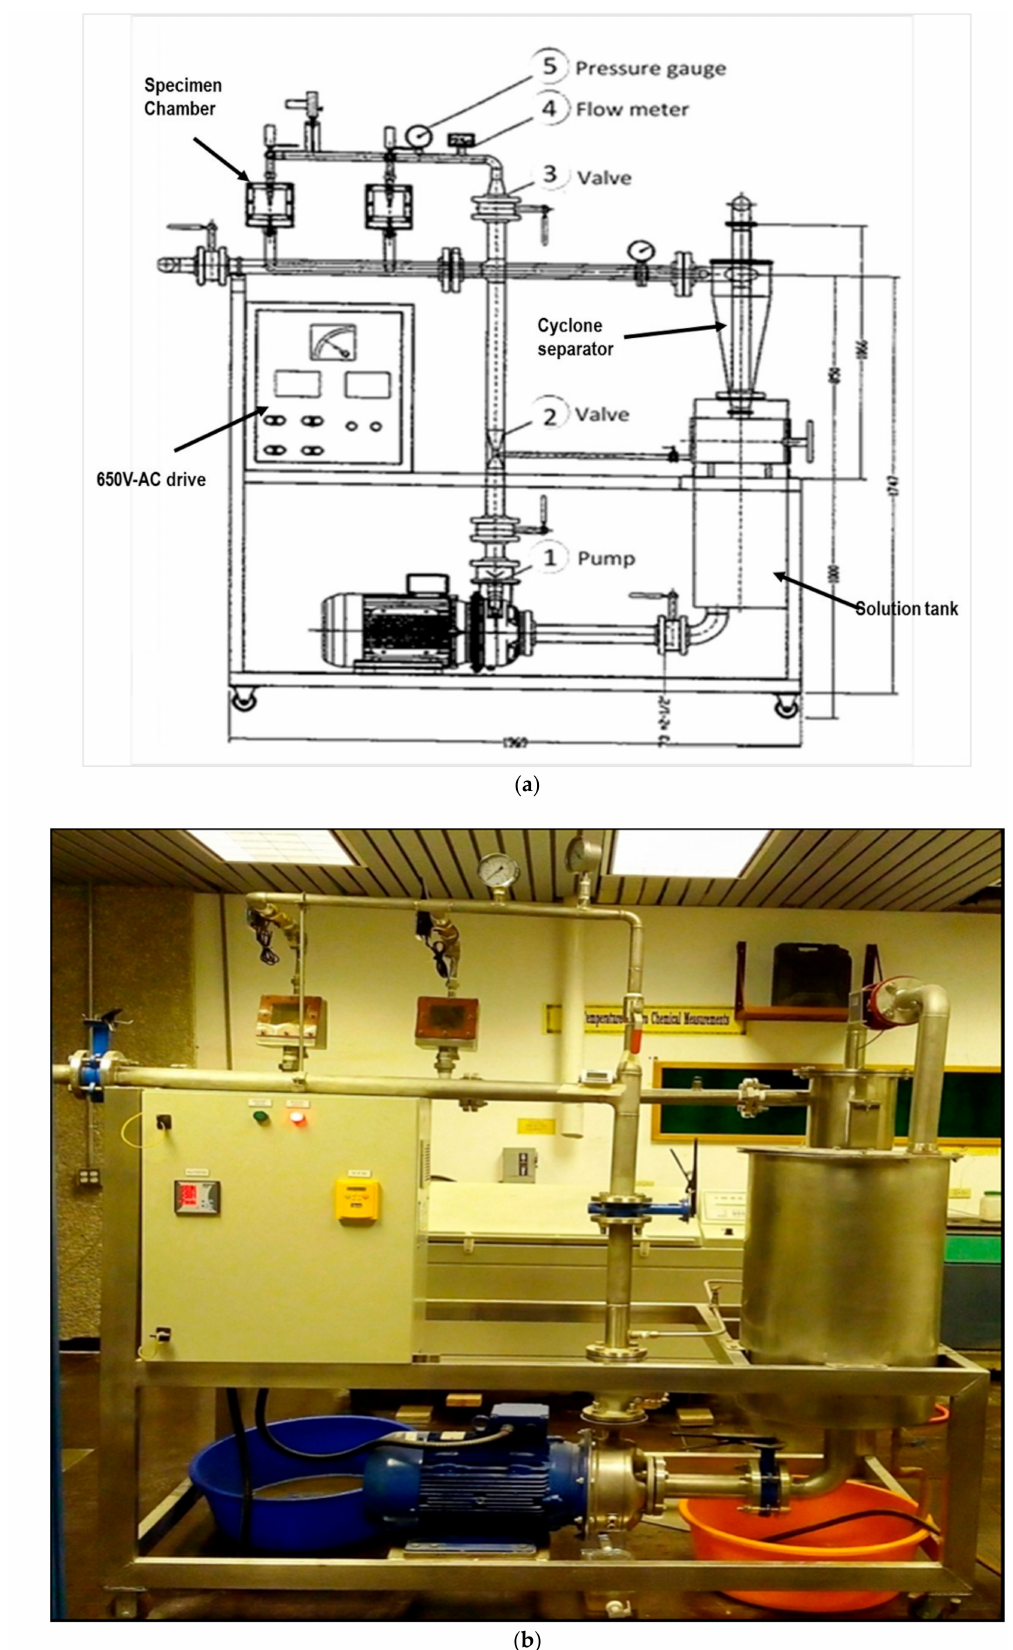
Figure 1. ( a ) Schematic of the flow loop showing the details of its components; ( b ) State of the art in-house designed mini flow